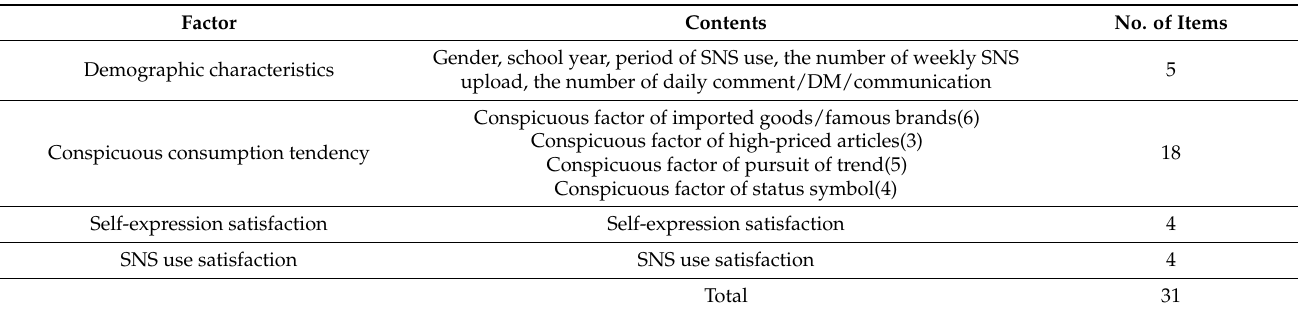
Table 2. Composition of